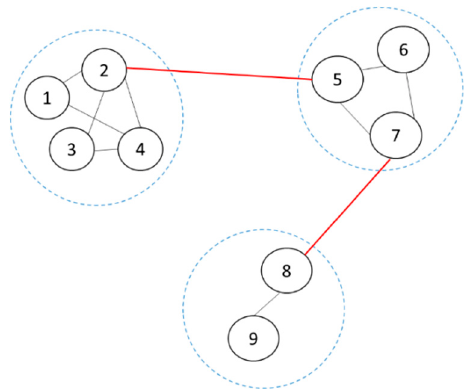
Figure 2. Schematic diagram of the network structure before combining.